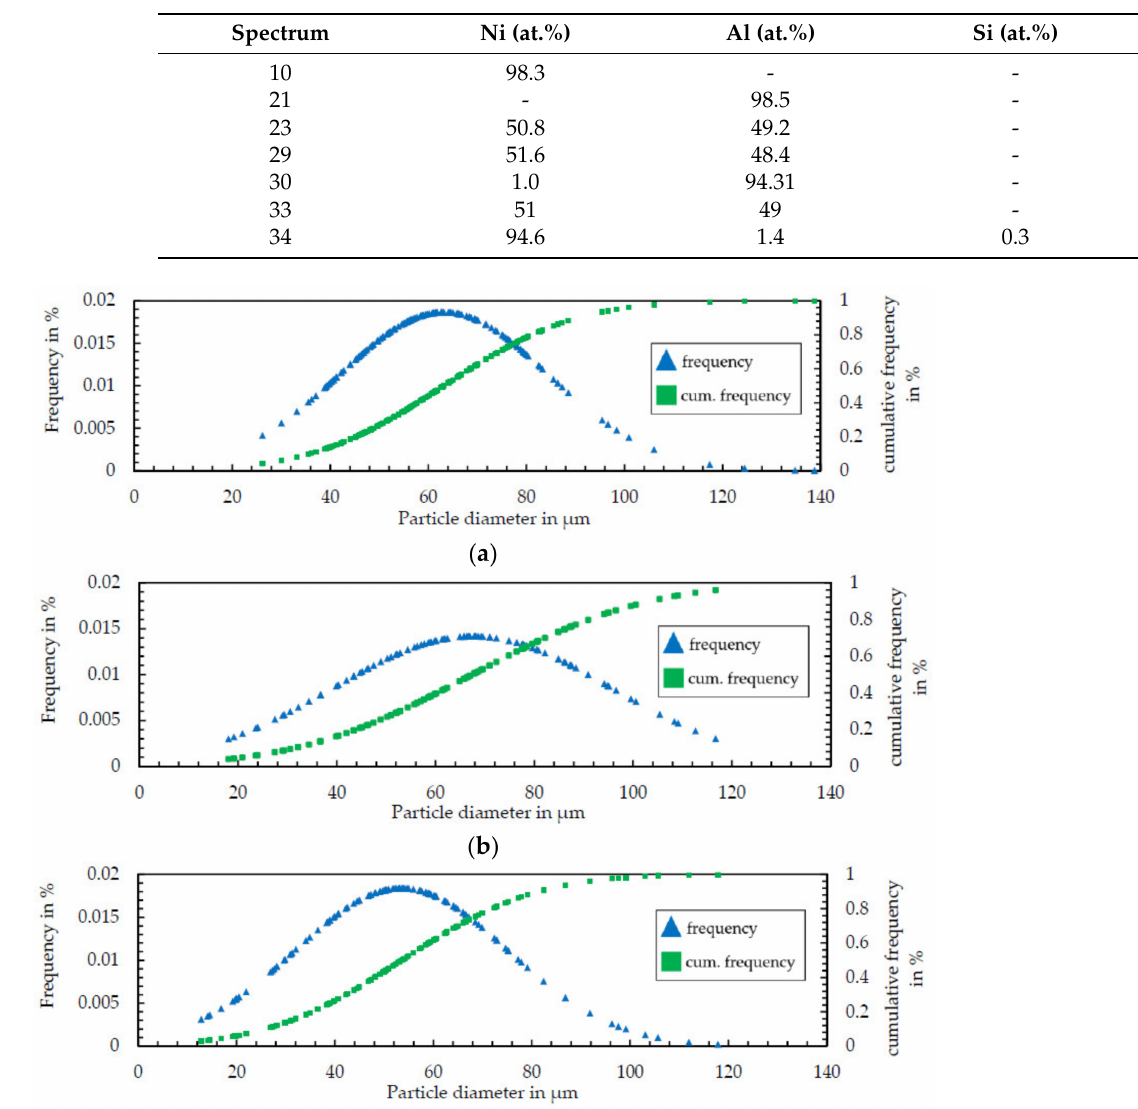
Table 5. Elemental composition of selected powder particles.